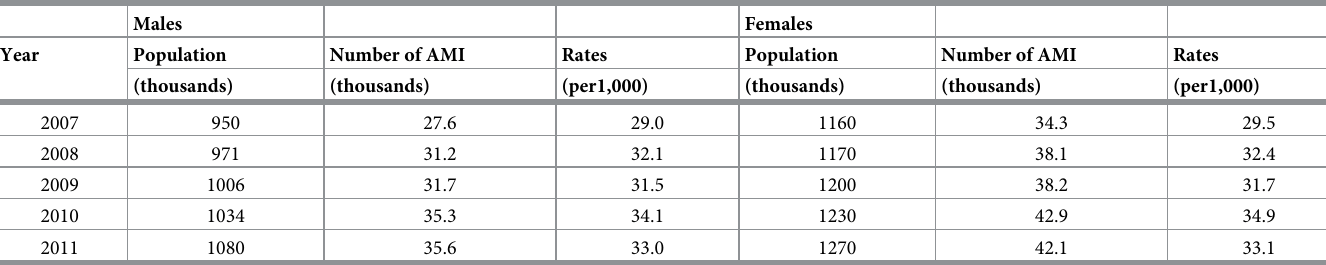
Table 1. Numbers and rates of acute myocardial infarction in Shanghai residents aged 65+ by gender, 2007–2011. Males